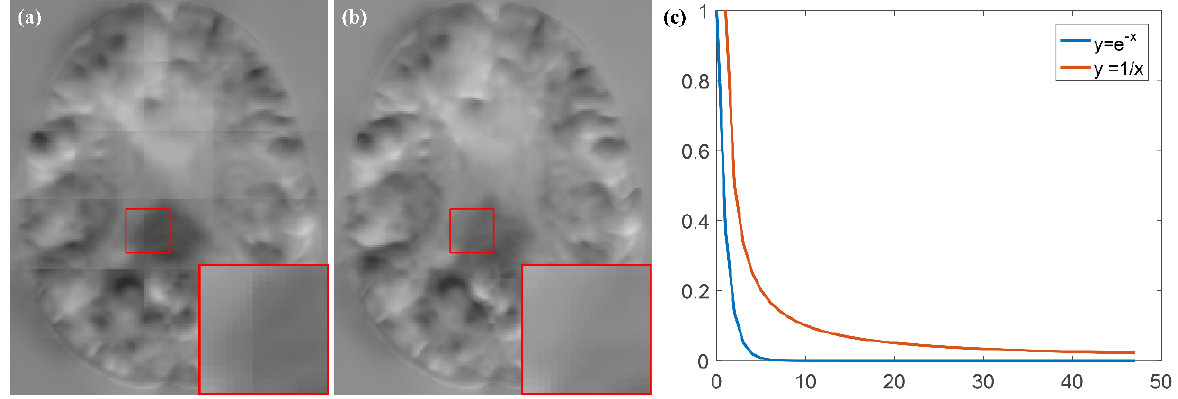
Figure 12. DDF results of different weighting methods and their corresponding function curves. ( a ) IDW; ( b ) proposed method; ( c ) weighting function curves.